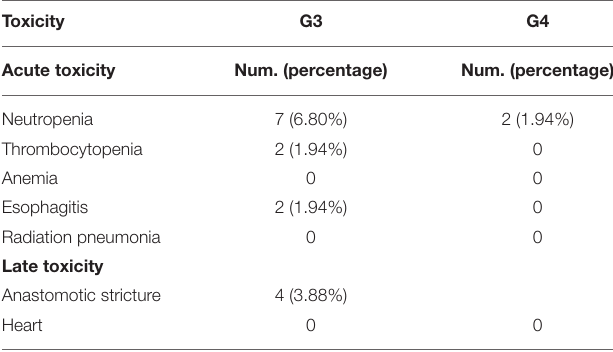
TABLE 3 | Acute or late G3/4